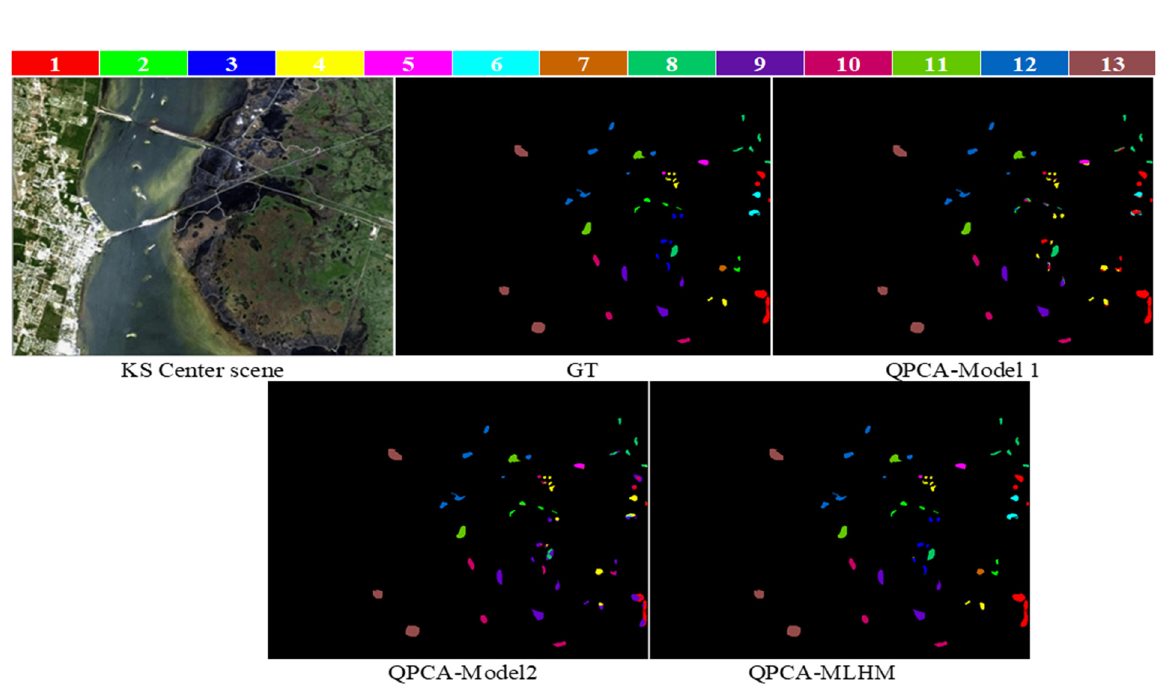
Figure 6. The results of both levels models for the KS_Center dataset.